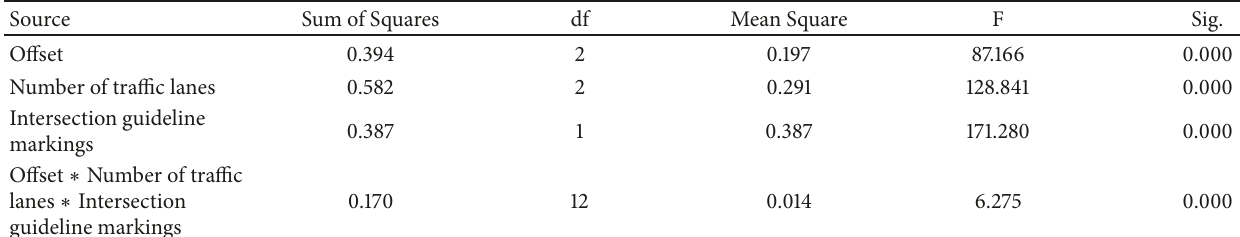
Table 3: Multifactor analysis of variance for through